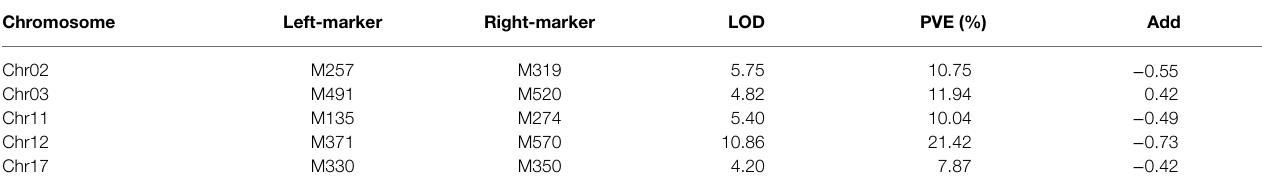
TABLE 6 | QTLs Preliminary mapping of the secondary segregating population.